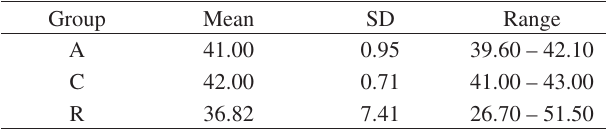
Table 2. Fracture torque value (Ncm). Group Mean